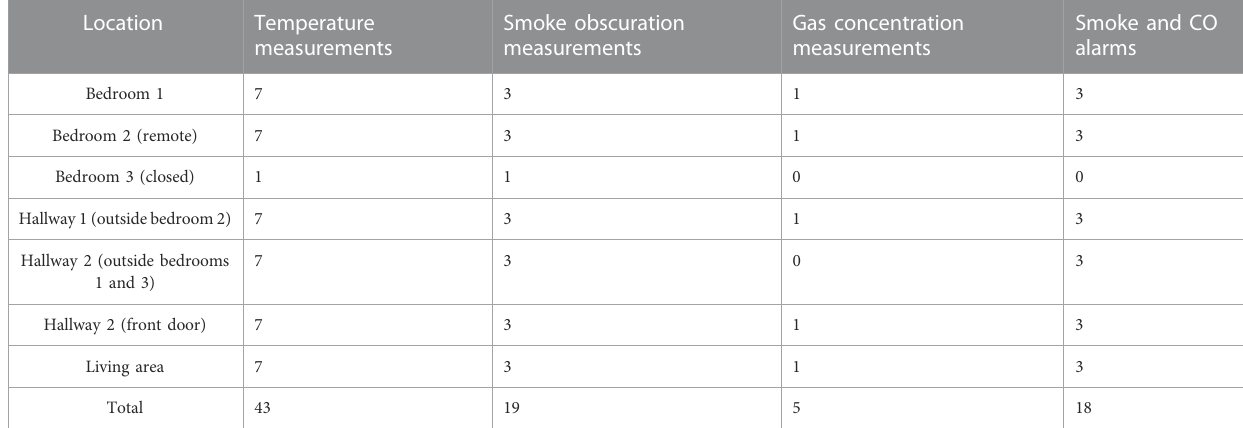
TABLE 2 Number of each sensor type in each location (Bukowski et al., 2003).